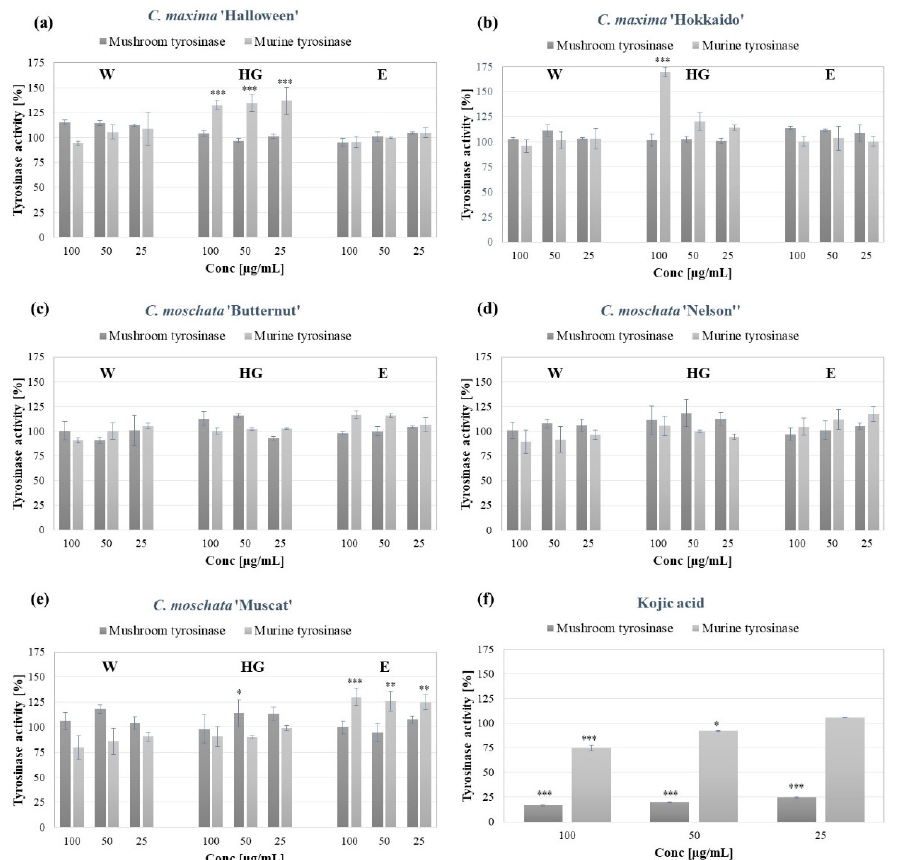
Figure 1. Mushroom and murine tyrosinase activities in the presence of the W (aqueous), HG (hydroglycolic) and E (ethanolic) extracts from C. maxima “Halloween” ( a ) and ‘Hokkaido” ( b ), C. moschata ‘Butternut’ ( c ), ‘Nelson’ ( d ) and ‘Muscat’ ( e ) cultivar peel extracts, in comparison with kojic acid ( f ); graphs show the mean tyrosinase activity ± SD, n = 3, * p < 0.05, ** p < 0.01, *** p < 0.001 .